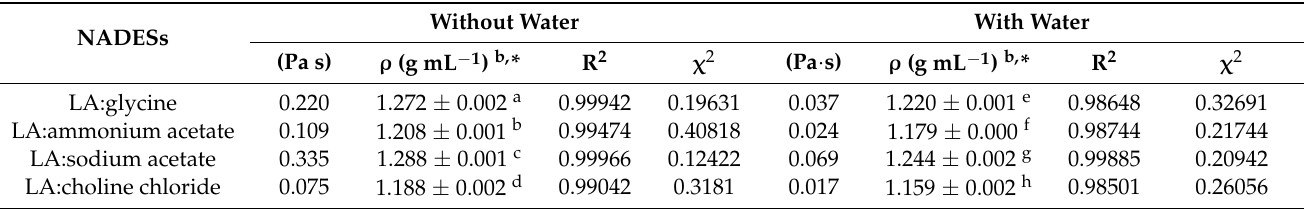
Table 1. Viscosity, density, and parameters of Newton’s model for